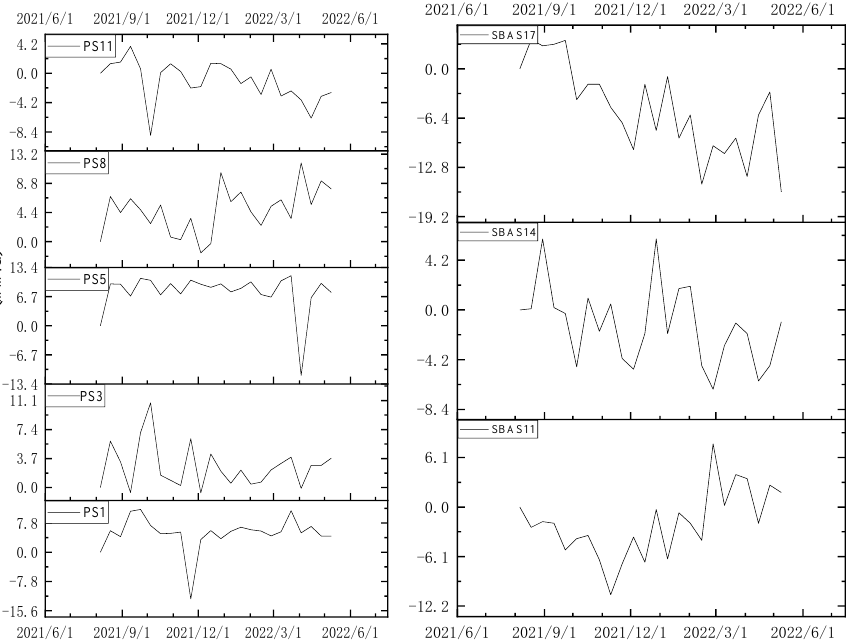
Figure 14. Overall settlement law of PS points near the embankment (PS11, PS8, PS5, PS3, PS1, SBAS17, SBAS14, SBAS11 corresponding to points H11, H8, H5, H3, H1, H17, H14, H11respectively).